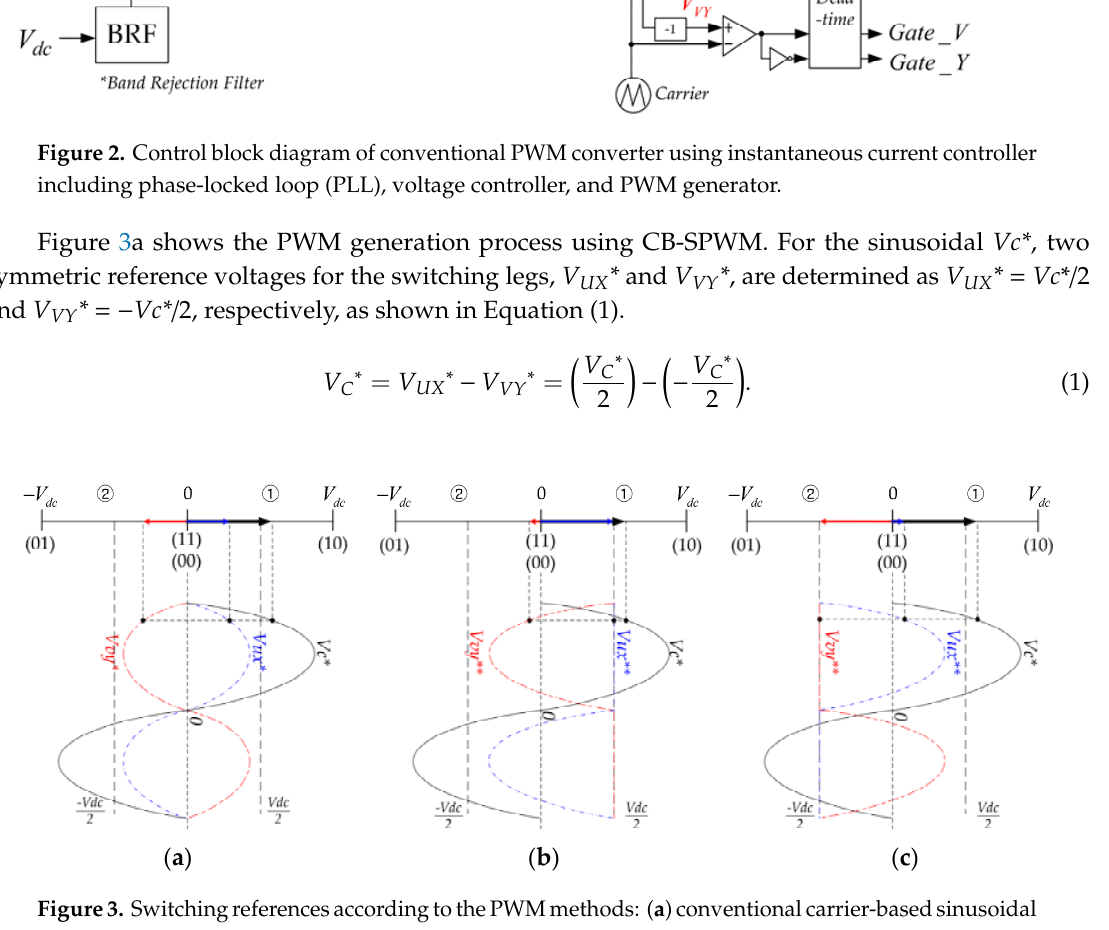
Figure 1. Circuit diagram of conventional single ‐ phase pulse ‐ width modulation (PWM) converter for high ‐ speed railway (HSR) propulsion system.